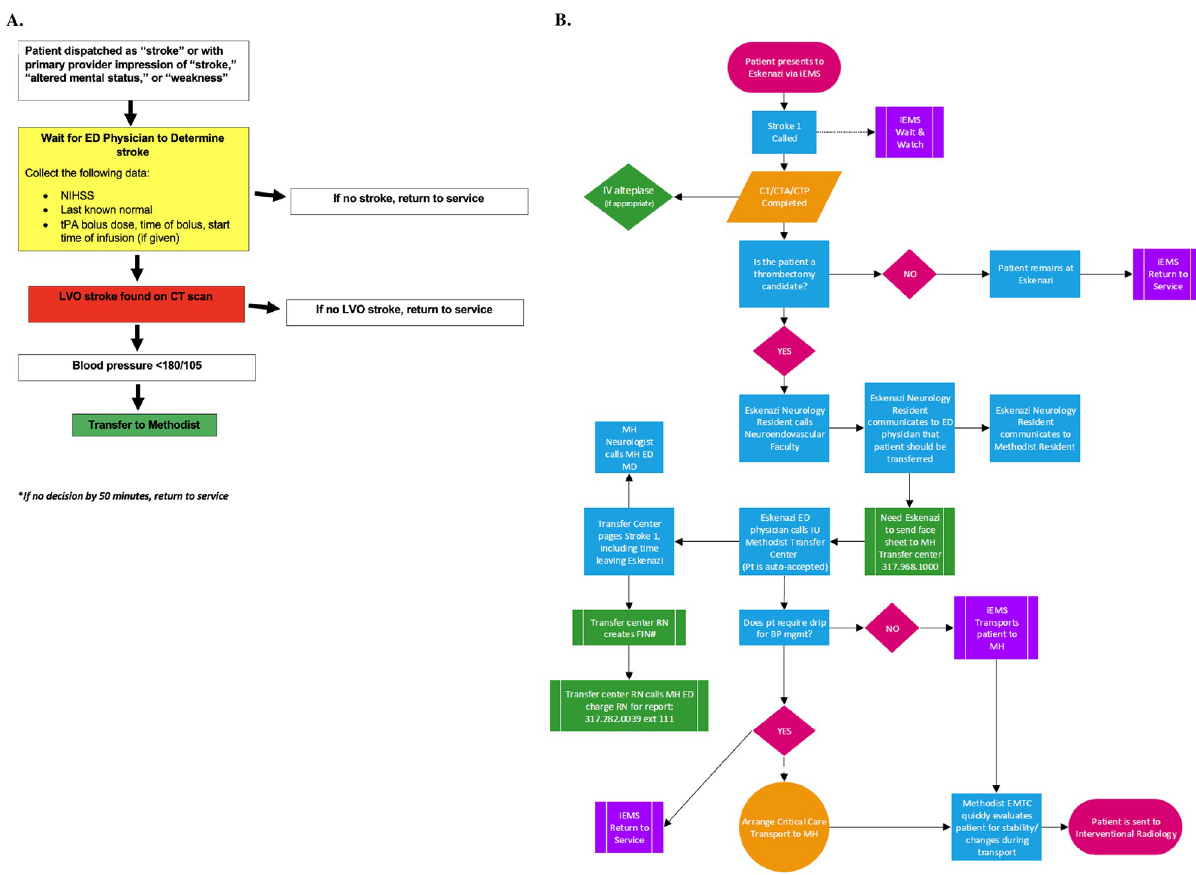
Fig 1. Novel protocol flowsheets. A) Brief protocol for Indianapolis EMS providers and B) Detailed in-hospital